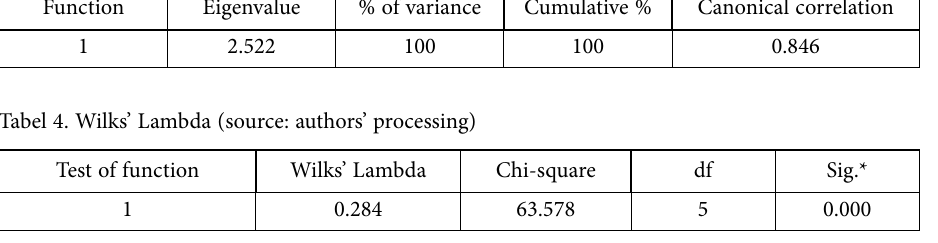
Table 3. Eigenvalues (source: authors’ processing) Function Eigenvalue % of variance